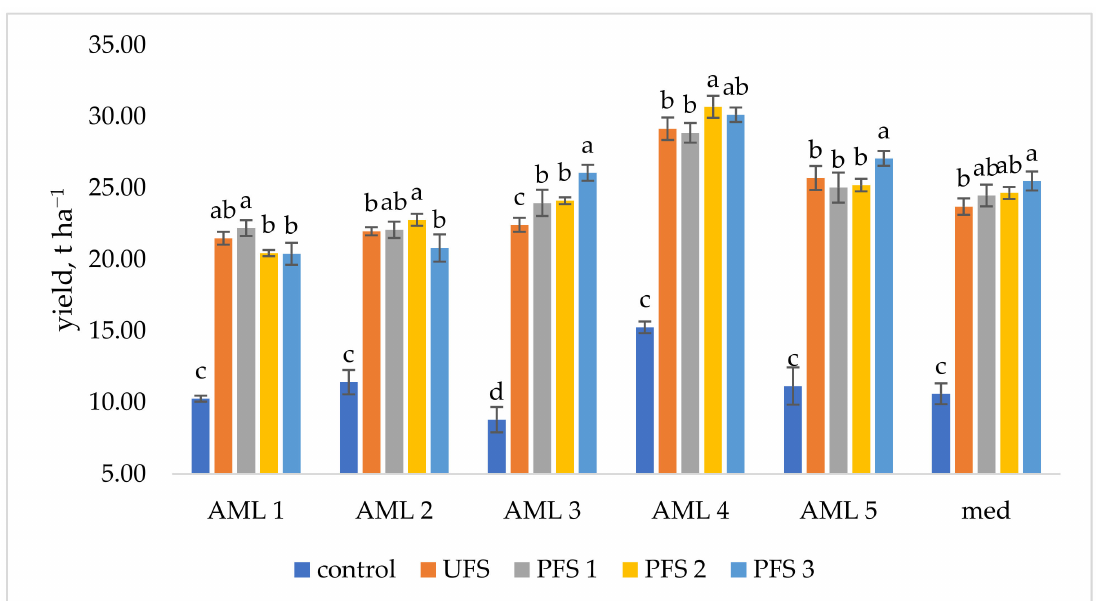
Figure 12. Influence of AML conditions and fertilization systems on the productivity of perennial grasses in